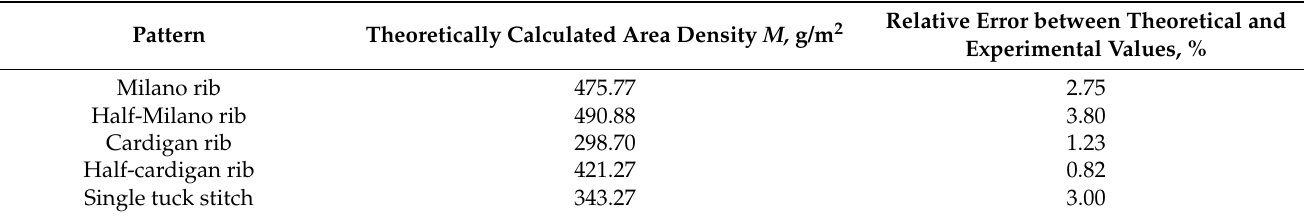
Relative Error between Theoretical and Experimental Values, %